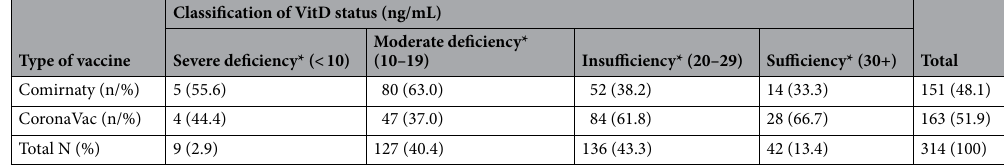
Table 6. Classification of the VitD status. W-0, Week zero; W-3, Week three; W-6, Week six; W-16, Week 16. *Classification of Vitamin D deficiency 22